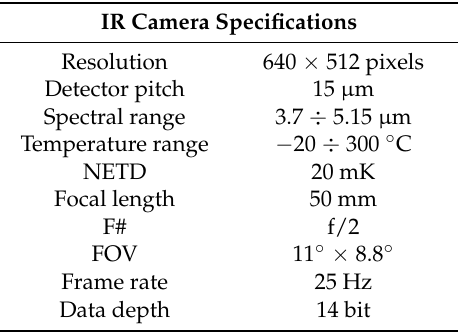
Table 2. Main specifications of the IR camera used to acquire the video sequences of the